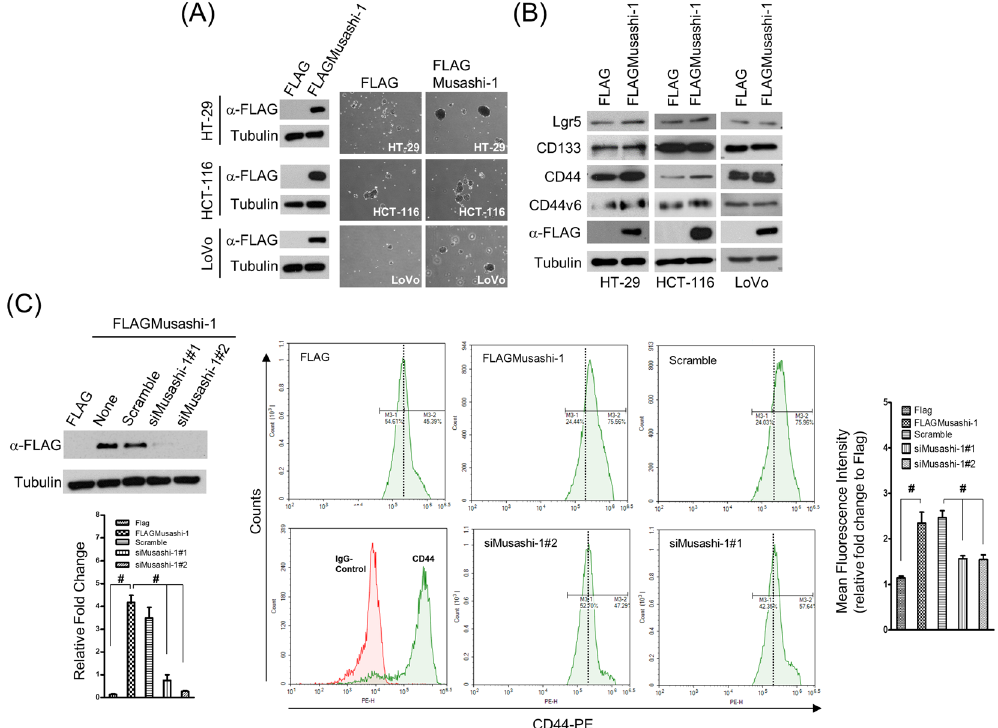
Figure 1. Musashi-1 promotes CD44 + CRC traits. ( A ) Establishment of Musashi-1-overexpressing CRC cells (FLAG/FLAGMusashi-1). HT-29, HCT-116, and LoVo cells were transfected with 3 × FLAG and 3 × FLAGMusashi-1 expression vectors, yielding the stable clones of HT-29, HCT-116, and LoVo cells with FLAG/ FLAGMusashi-1, respectively. Stably transfected cells were selected by G418 (4 mg/mL) in culture medium for 4 weeks. Total protein of selected stable cell lines was obtained by lysis in RIPA buffer with protease and phosphatase inhibitors. Samples were subjected to immunoblotting analysis with a monoclonal anti-FLAG antibody (left panel). Spheroid formation was determined by culturing FLAG (HT-29, HCT-116, and LoVo cells) and FLAGMusashi-1 (HT-29, HCT-116, and LoVo cells) cells in spheroid formation buffer for 2 weeks. Images were acquired with Olympus cellSens software v1.12 (right panel). ( B ) Immunoblotting analysis of CSC marker expression in HT-29, HCT-116, and LoVo cells /FLAG and HT-29, HCT-116, and LoVo cells/ FLAGMusashi-1 cells. Total cell lysates of FLAG- or FLAGMusashi-1-overexpressing stable cell lines were collected in RIPA lysis buffer. Total proteins were subjected to immunoblotting analyses with Lgr5-, CD133-, CD44-, and CD44v6-specific antibodies. ( C ) Silencing of HT-29/FLAGMusashi-1. HT-29/FLAGMusashi-1 cells were transfected with Musashi-1-specific siRNAs using LipoMax (Invitrogen) for 72 h. Total cell lysates were collected and subjected to immunoblotting analyses using a monoclonal anti-FLAG antibody. Musashi-1 knockdown in HT-29/FLAGMusashi-1 cells (upper left panel). HT-29/FLAGMusashi-1 cells were transfected with pre-designed siRNAs against Musashi-1 by liposome-mediated nucleic acid delivery. Relative fold change is indicated in the bar chart (lower left panel). Error bars indicate the mean ± SD from three independent experiments. # p < 0.05. After 72 h, HT-29/FLAG and HT-29/FLAGMusashi-1 cells were subjected to CD44 expression analysis by flow cytometry (middle panels). Relative fold change is indicated in the bar chart (right panel). Error bars indicate the mean ± SD from three independent experiments. # p <